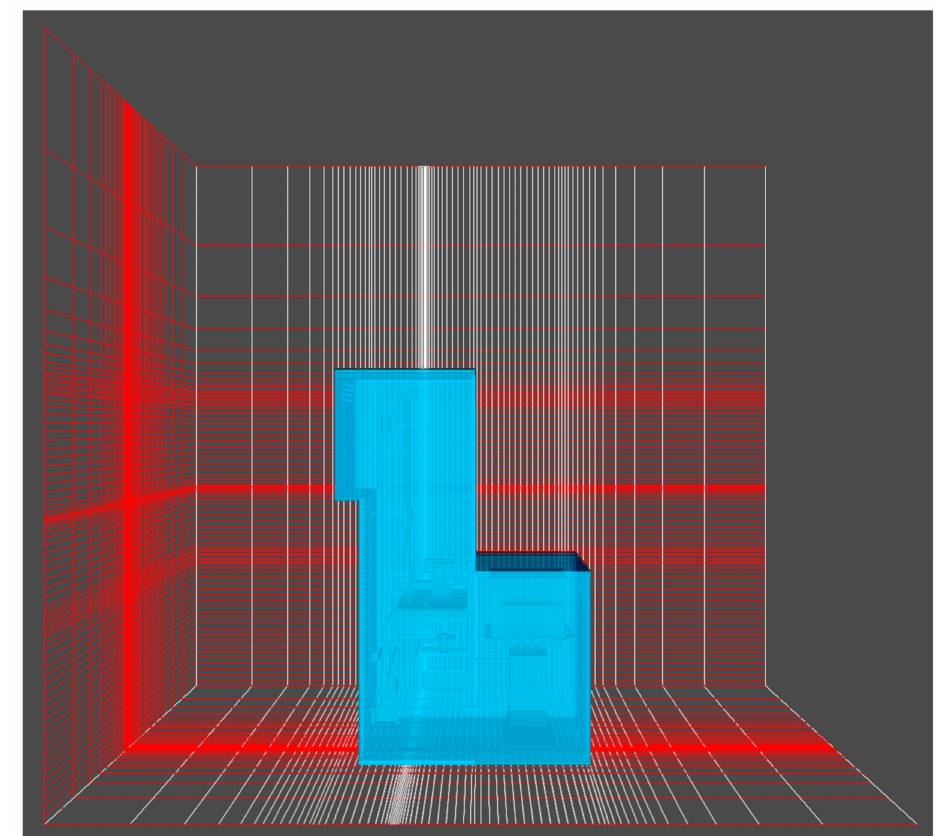
Figure 2. The computational domain and the mesh (Case